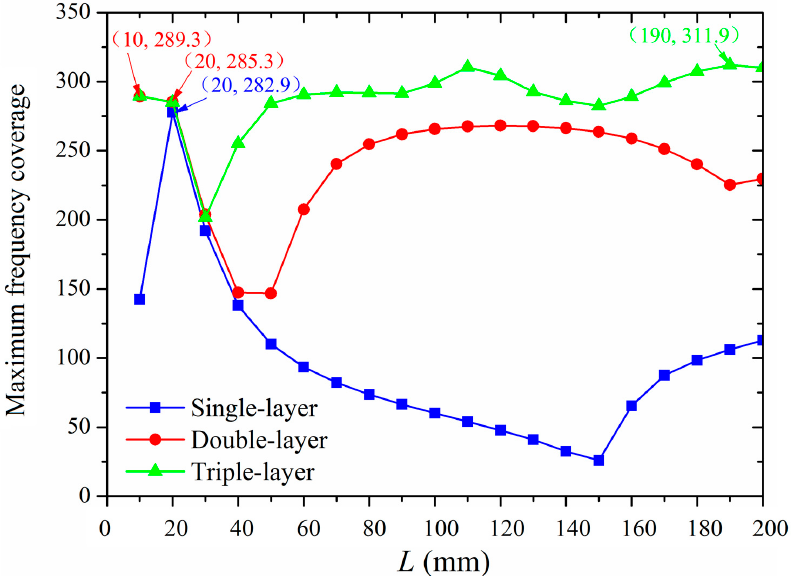
Figure 11. The maximum frequency coverage of single-layer, double-layer, and triple-layer MPPs at a different L .